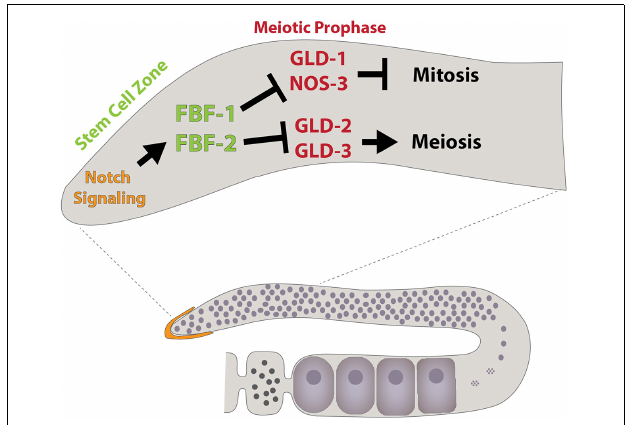
FIGURE 5 | Schematic illustrating some components that regulate C. elegans germline development, including the Puf family members FBF-1 and FBF-2. Modeled after Ellenbecker et al.